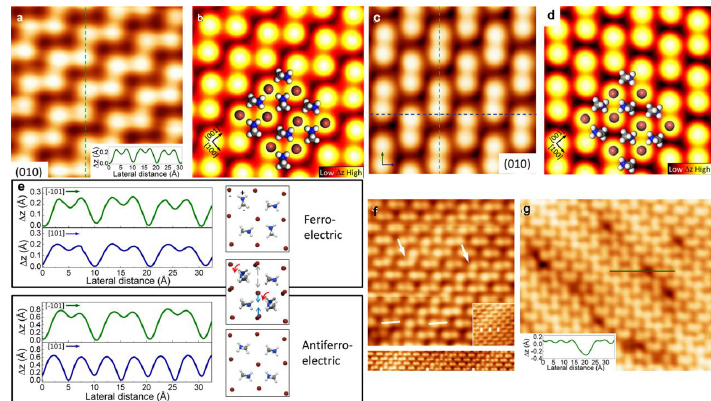
Figure 9. ( a ) Atomically resolved STM topography of the perovskite surface. Inset: Height profile along dashed line in the image. Image size: 31 × 31 Å 2 (U= −5 V, I = 0.1 nA); ( b ) Simulated STM image of the (010) plane of the orthorhombic crystal with surface reconstruction; ( c ) Image size: 31 × 31 Å 2 (U=-9 V, I = 0.1 nA); The arrows and dashed lines indicate the direction of the height profiles shown in part e; ( d ) Corresponding calculated image; ( e ) Comparison of height profiles and the corresponding model. The arrows indicate the rotational and positional change of the MA molecules and the Br ions, respectively, between the ferroelectric and antiferroelectric domain; ( f ) Start of the dislocation rows indicated by the white arrow. The angled lines indicate the modified Br atom positions adjacent to a dislocation row. Inset: Three dislocation rows beside each other. Bottom: Periodic arrangement of the dislocation rows; ( g ) STM image of defects on the surface. Image sizes: ( f ) 64 × 64 Å 2 , inset 56 × 55 Å 2 , bottom 164 × 23 Å 2 ; ( g ) 92 × 103 Å 2 . U = − 9 V, I = 0.1 nA. The figure was taken from Reference [59] with